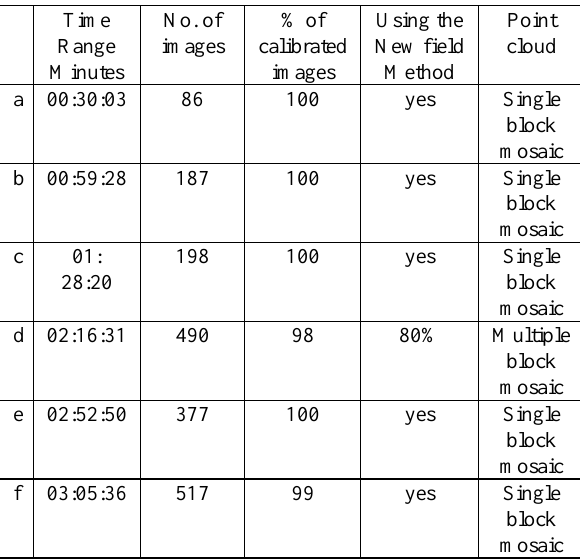
Table 2. Time Range to Determine the Level-of Tolerance of the Miniature Sensors